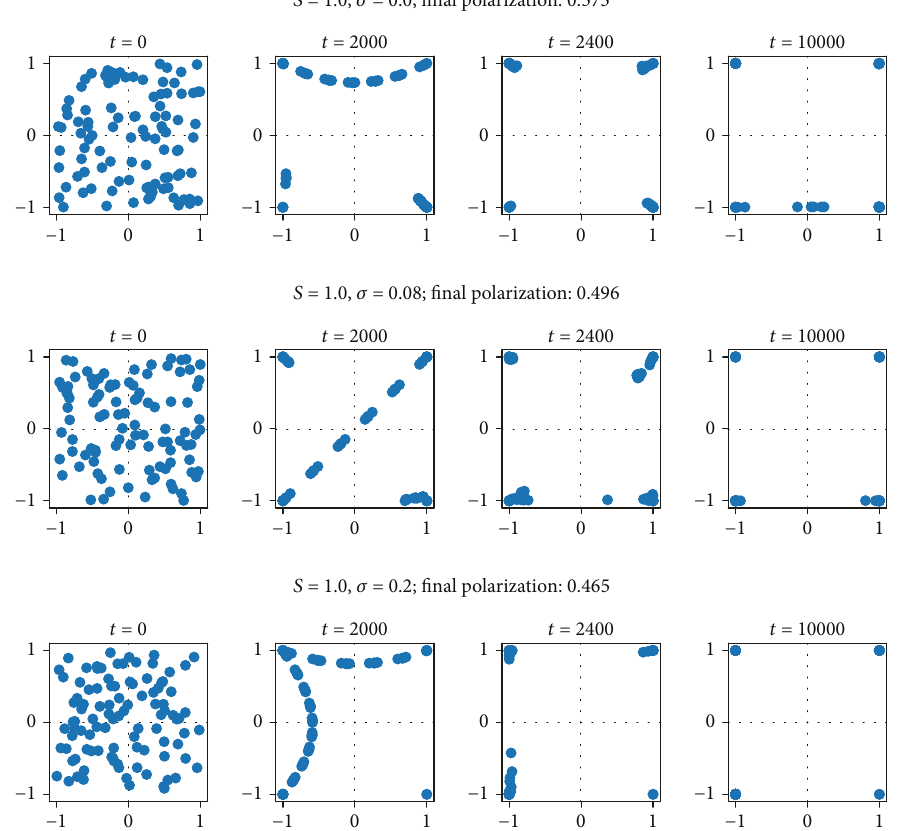
Figure 15: Exemplar spatiotemporal dynamics of agent opinion coordinates with K = 2 and S = 1 0 for σ ∈ 0 0,0 08,0 2 . Before the random long-range ties are added at t = 2000 , extremists pull centrists to the extremes, but more centrist agent caves are balanced between more extreme caves. When long-range ties are added, the balance is broken and agents proceed to move to one of the extremes. Because at least some extremists held each of the corners, centrist agents do not move only to polar opposite corners, but in many cases to the nearest corner contained a neighboring (in the network sense) agent.